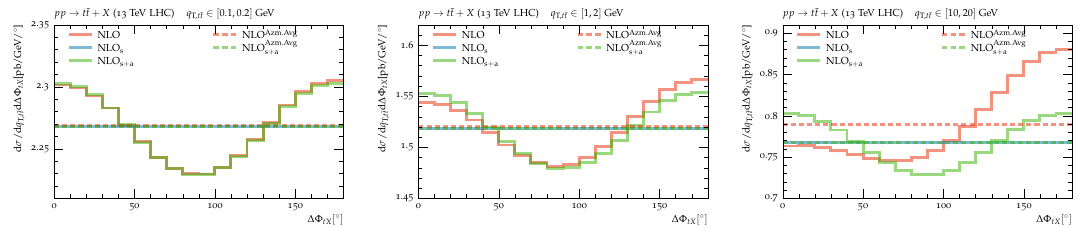
Figure 10 . Comparison of the NLO double differential spectra d σ / (d q T d∆Φ tX ) , shown as distribu- t ¯ t tions of ∆Φ tX in slices of q T . Herein, NLO represents the QCD result calculated in S HERPA [169–171]. NLO s labels the azimuthally symmetric and NLO s+a marks the full, i.e. azimuthally symmetric and asymmetric , contributions derived from SCET II + HQET, respectively. The superscript “ Azm . Avg ” denotes the azimuthally averaging operation on the exact and approximate